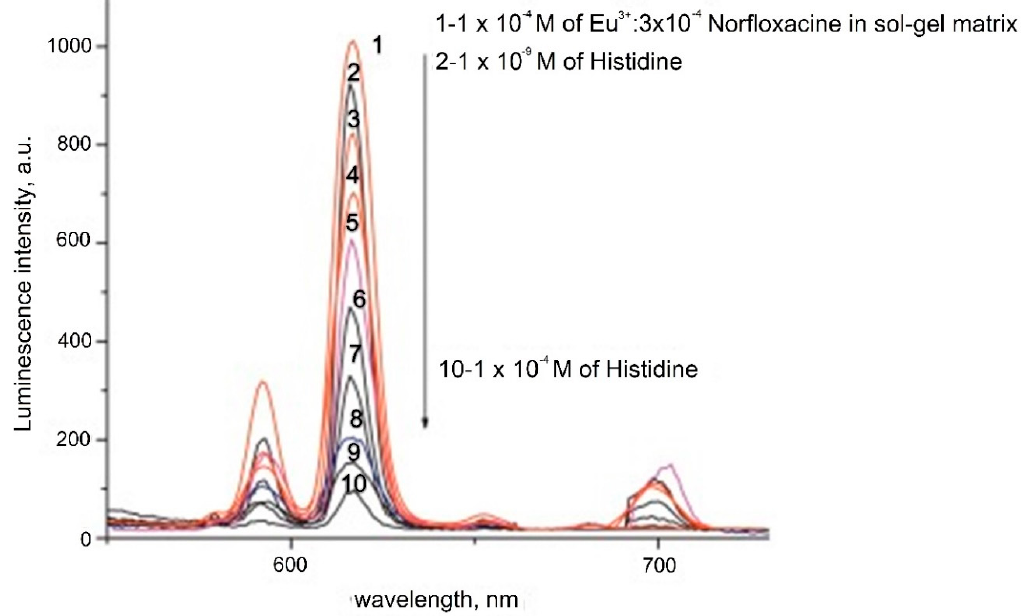
Figure 20. Luminescence emission spectra of nano Eu–norfloxacine complex doped in sol–gel matrix in the presence of different concentrations of histidine in acetonitrile (curve 1: control, curve 2: 1 nM–curve 10: 100 µM). Reprinted [172], Copyright 2015, with permission from Elsevier.